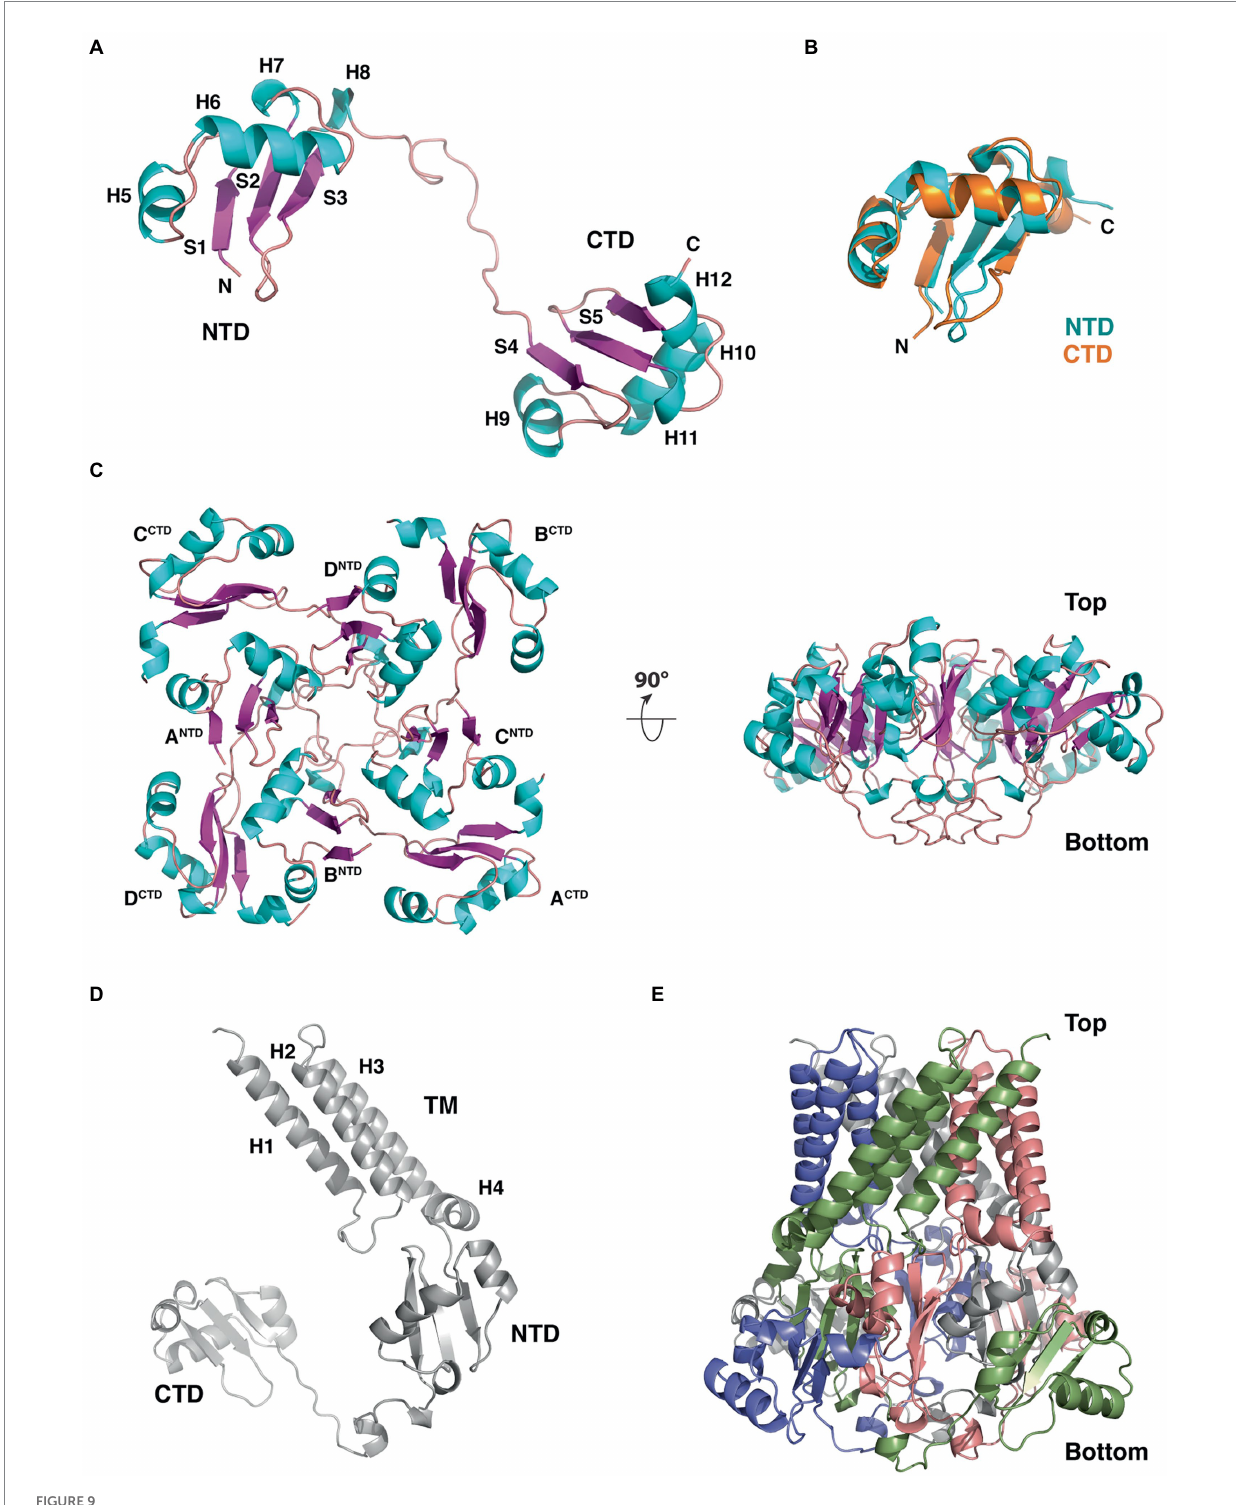
FIGURE 9 Structure, domain organization and oligomerization state of B. subtilis YetF. (A) Ribbon diagram of the YetF monomer lacking the N-terminal transmembrane helices (PDB ID: 3C6F), with the secondary-structure elements labeled. Helices and β strands are shown in blue and purple, respectively. (B) Superimposition of the NTD (blue) and CTD (orange) subdomains of YetF. (C) Top and side views of the YetF tetramer observed in the crystal structure. (D) Computed full-length YetF monomer structure by AlphaFold (Jumper et al., 2021) including the N-terminal TM helices. (E) Tetrameric assembly of the full-length YetF, shown in an orientation similar to that in ( C , right).